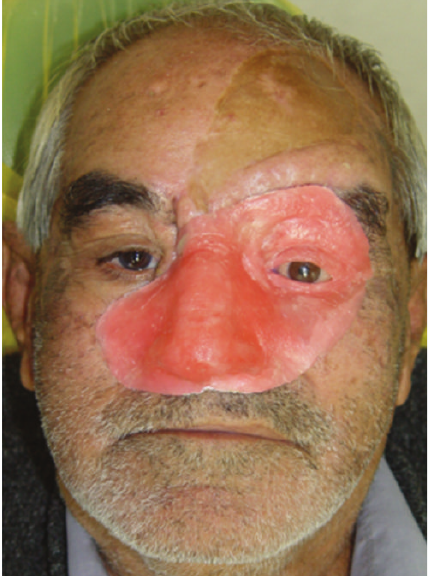
Figure 4: Wax pattern tryin.